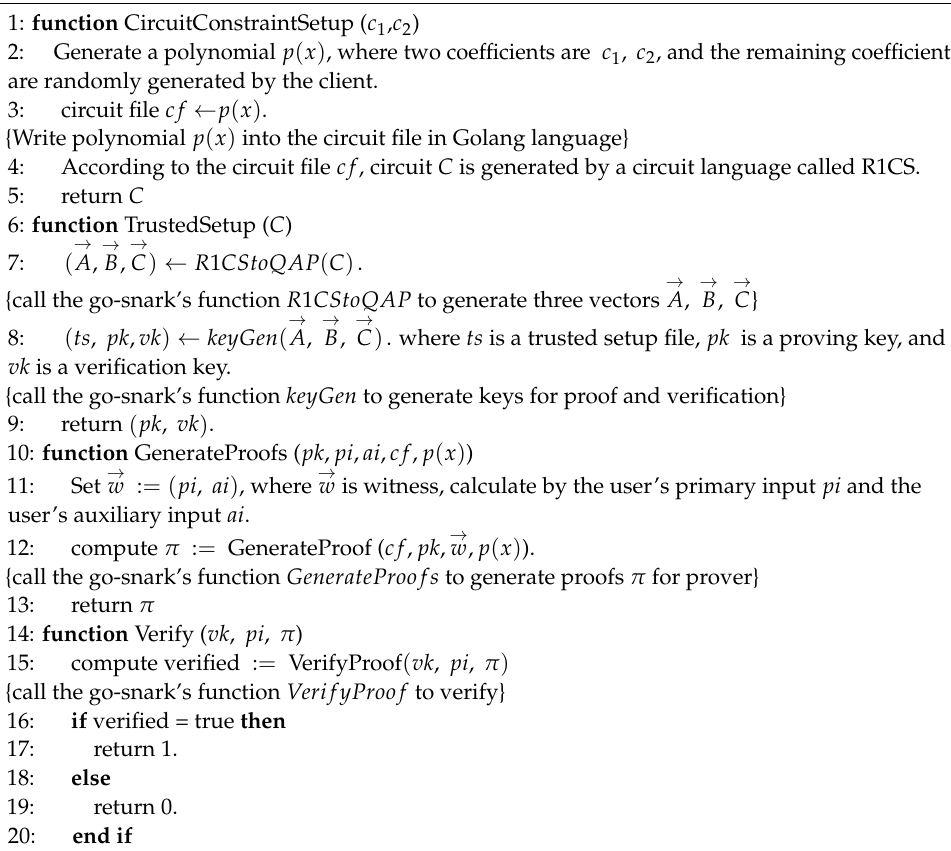
Algorithm 1 Zero-knowledge proof